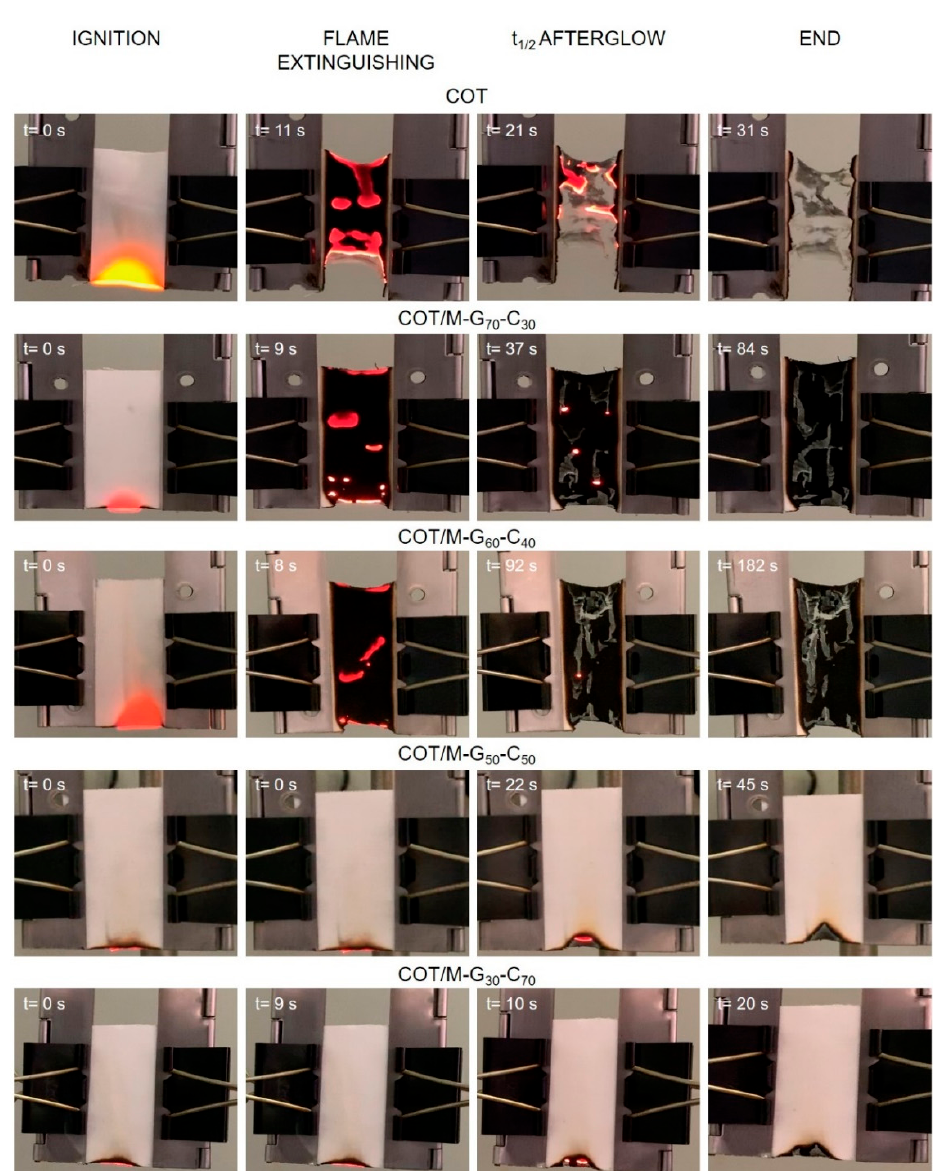
Figure 4. Snapshots of untreated, copolymeric PAA-treated cotton in vertical flame spread tests. Add-ons: 16.4, 16.3, 16.0 and 16.2% for COT/M–G 70 –C 30 , COT/M–G 60 –C 40 , COT/M–G 50 –C 50 and COT/M–G 30 –C 70 , respectively. Table 5. Combustion data of untreated and PAA-treated cotton fabrics from vertical flame spread tests.